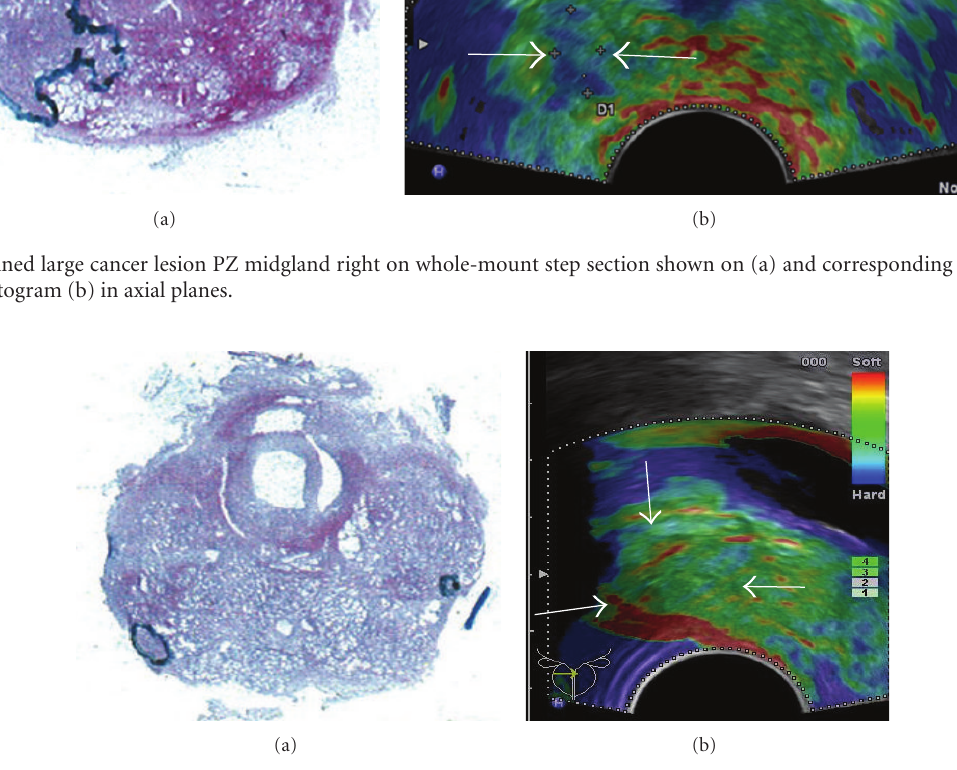
Figure 5: Outlined small cancer lesion PZ base right on whole-mount step section shown on (a) and corresponding elastogram on (b) in axial plane with arrow marked soft